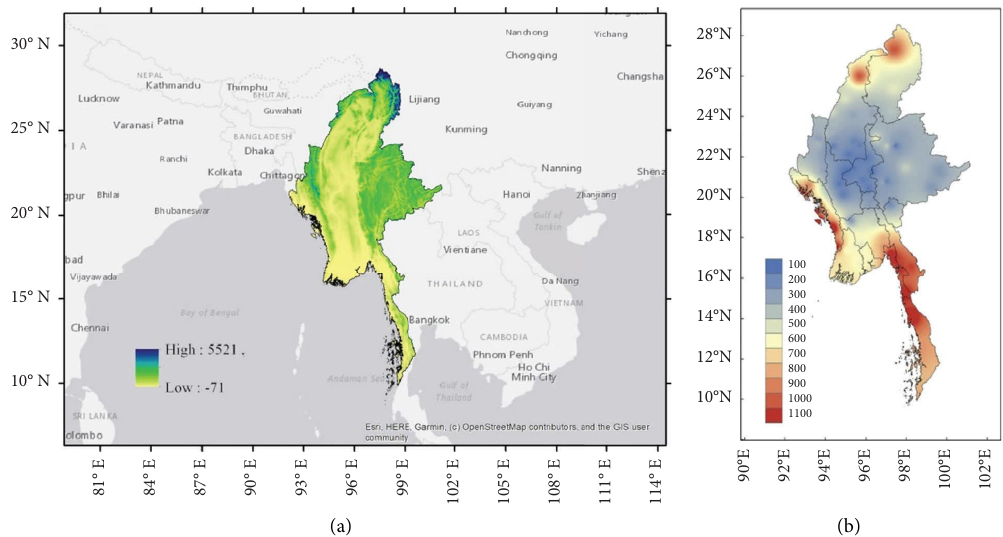
Figure 2: Study area: (a) Myanmar orography ( m ) and neighboring and (b) climatology annual total rainfall (mm) based on observation data during 1981–2020.